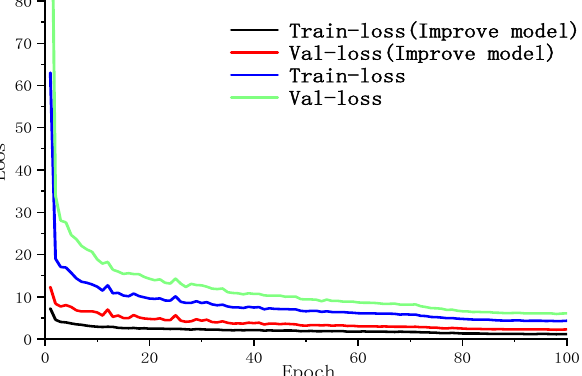
Figure 13. YoLoX-Nano loss function curve before and after improvement.